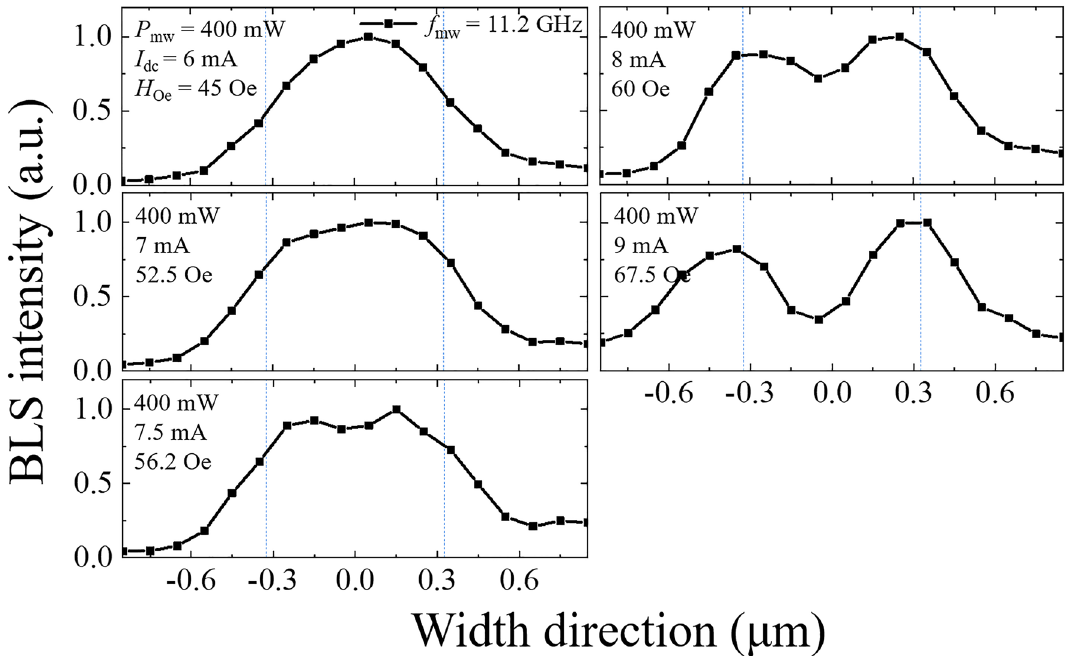
Figure 5. Mode profiles along the width direction. BLS intensities are measured at a frequency of f sw = 5.6 GHz. The measurement conditions of the microwave power ( P mw ), dc current ( I dc ) and Oersted field ( H Oe ) are shown in each profile. The microwave frequency ( f mw ) is 11.2